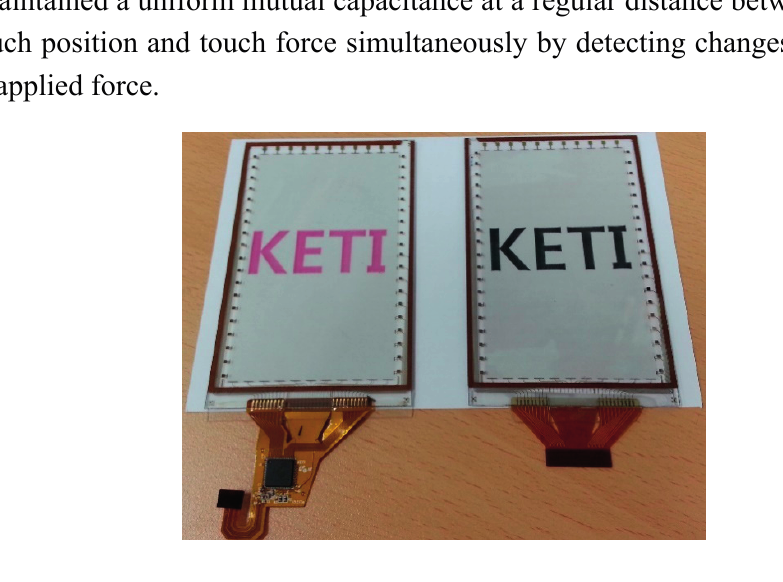
Figure 4. Image of the fabricated SWCNT based force sensing touchscreen composed of substrates of transparent glass and PET film and a force sensing inner layer of elastic silicone inserted between the two